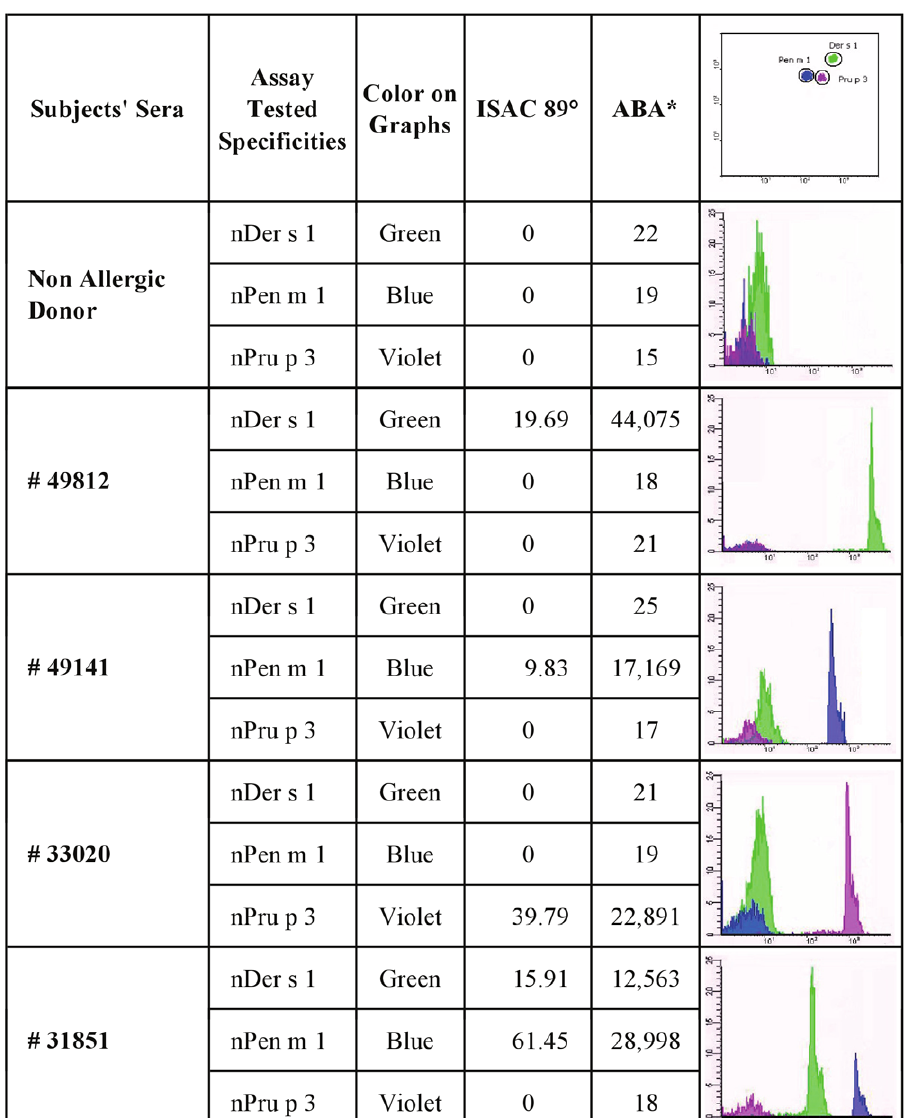
Figure 3. Testing human sera containing specific IgE on allergen conjugated micro-beads. Three human individual serum samples (49812, 49141, 33020), each of them known to have specific IgE to one allergen and not to the others were tested on the three micro-beads present in the same tube. Serum 31851 was from a subject recognizing nDer s 1 and nPen m 1, but not nPru p 3. A non allergic donor was used for control purposes. # Serum sample numbers; u Values are expressed as kU/l; * Values are expressed as Median Fluorescence Intensity [MFI]. Upper right corner: an example of micro-bead fluorescence clusters.